Question: State the chart type depicted above.
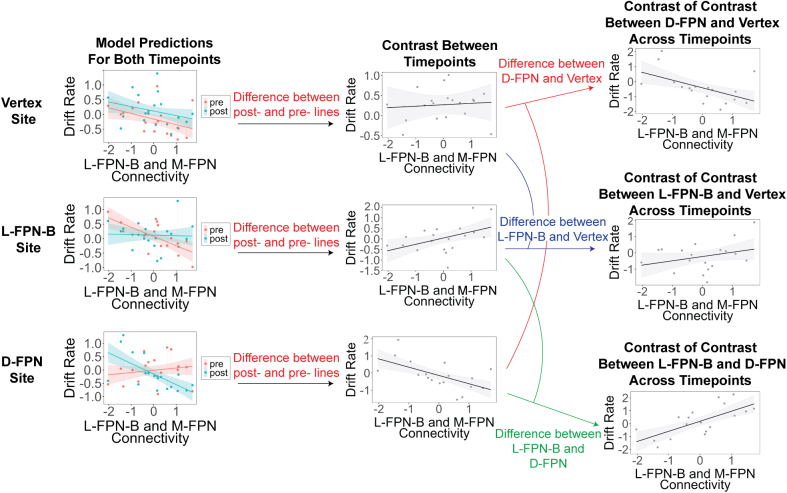
Answer: line